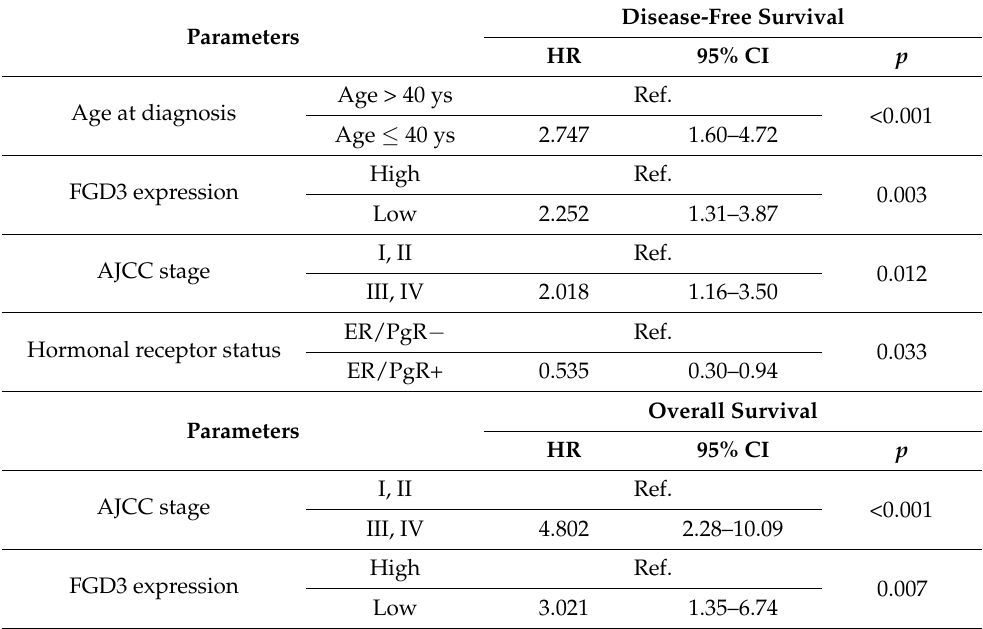
Table 2. Multivariate Cox analysis for disease-free survival and overall survival. Abbreviations: Ref. Reference